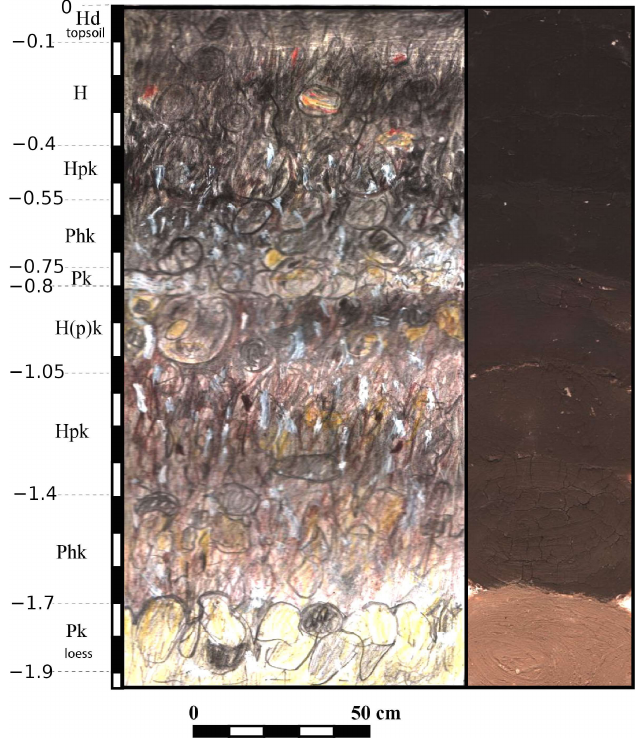
Figure 5. Mohylna 3. Soil-section 1. Captions: see Supplementary Table S2. Left column: soil horizons’ indices, dotted lines indicate changes of horizons; central column: schematic drawing; right column: photos of actual soil textures from respective horizons of the section, taken afield by gluing a respective sample to a sheet of paper; Elaboration—ZM.